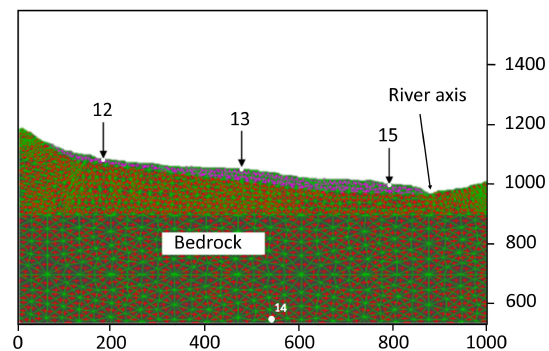
tual model. History (measurement) points 12, 13 and 15 (white dots) located, respectively, on the upper, middle and lower blocks corre- spond to the surface area where parameters were monitored (e.g. the x acceleration). Point 14 is located at the base of the model, within the bedrock. The axis of the Kanyosha River is located to the right of history point